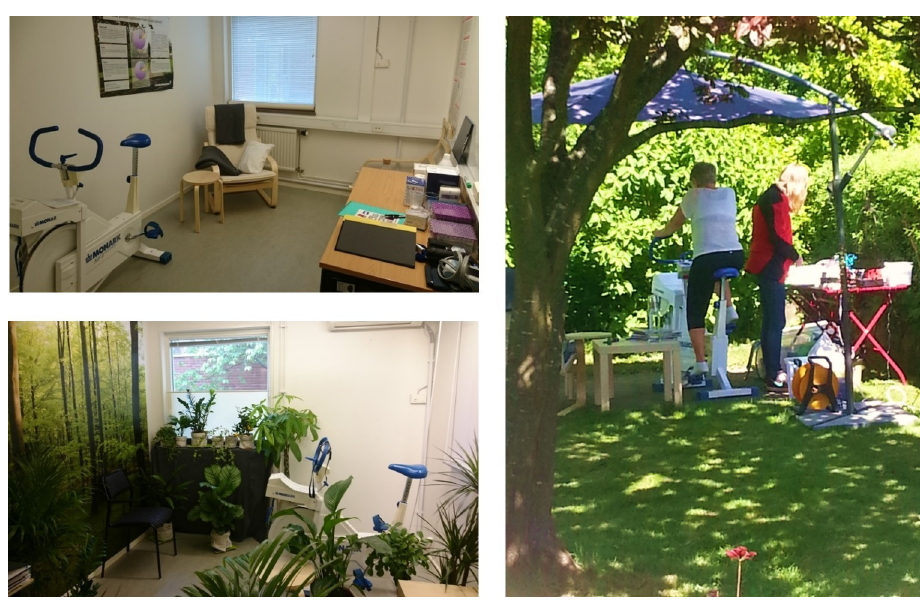
Fig 2. The three different experimental environments representing three levels of exposure to nature: Indoors, simulated indoors and outdoors.